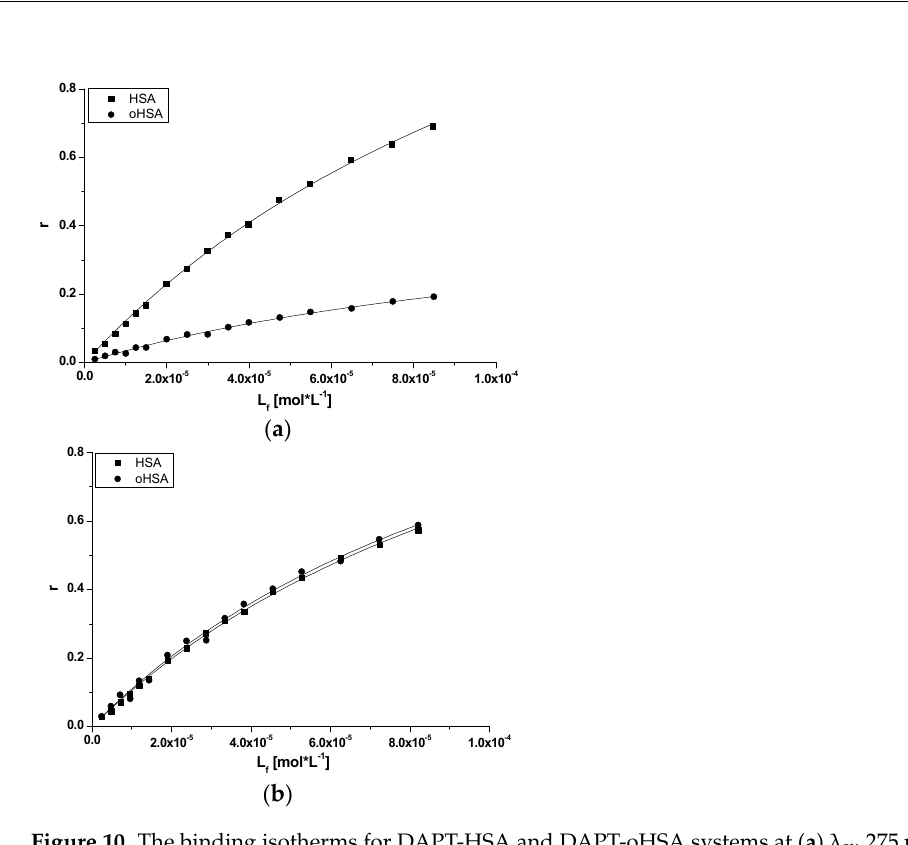
Figure 10. The binding isotherms for DAPT-HSA and DAPT-oHSA systems at ( a ) λ ex 275 nm and ( b ) λ ex 295 nm.